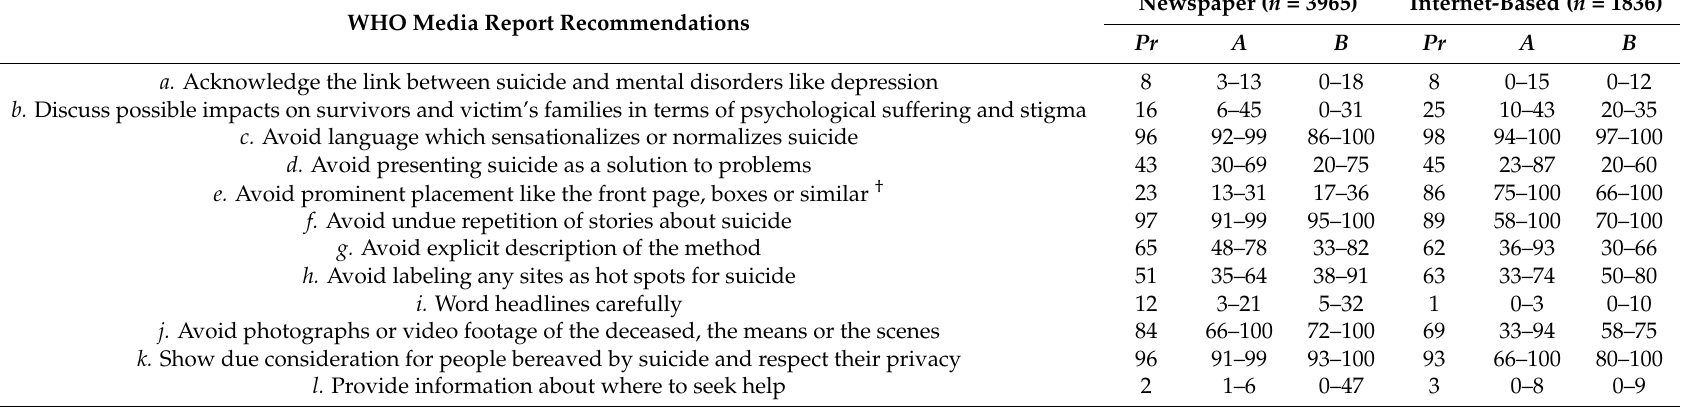
Table 1. Proportions of reported suicide news that adhered to WHO recommendations in the 10 most influential newspaper and Internet-based media sources in China,